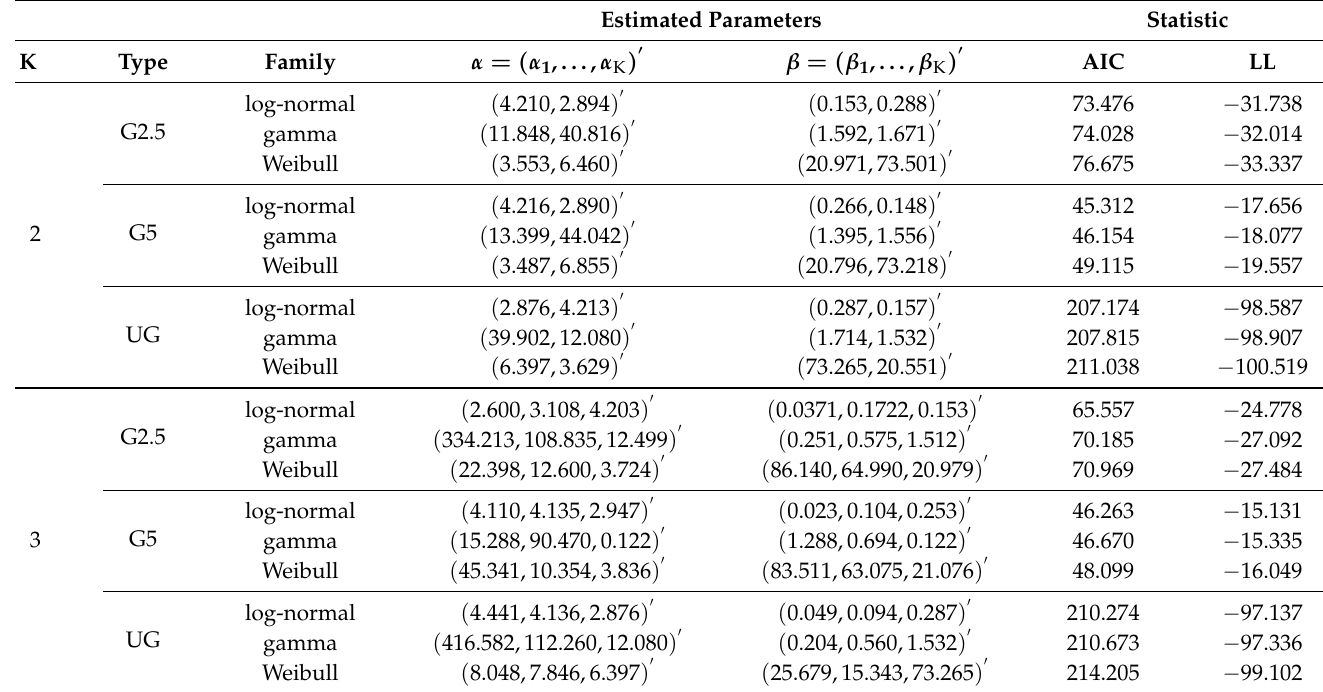
Table 1. Parameter estimates and goodness-of-fit statistics for the mixture of log-normal, gamma, and Weibull distributions fitted to sample 1 when DBH data are ungrouped (UG), grouped in classes of width 2.5 cm (G2.5), and grouped in classes of width 5 cm (G5) . It should be noted that the estimated vector of mixing parameters is not given for the sake of saving space. Estimated Parameters